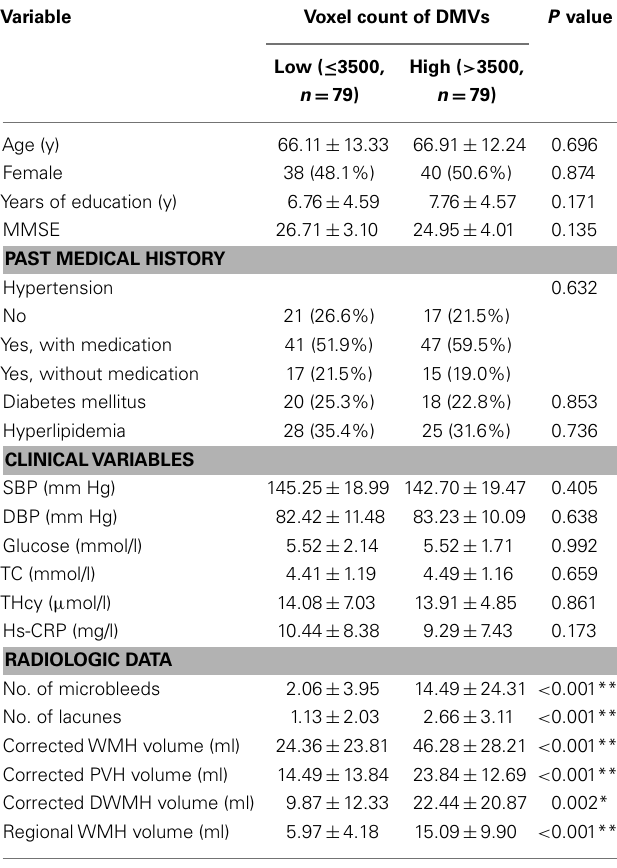
Table 3 | Baseline characteristics ofWMH patients classified according to the number of voxels of the deep medullary veins dichotomized at the median